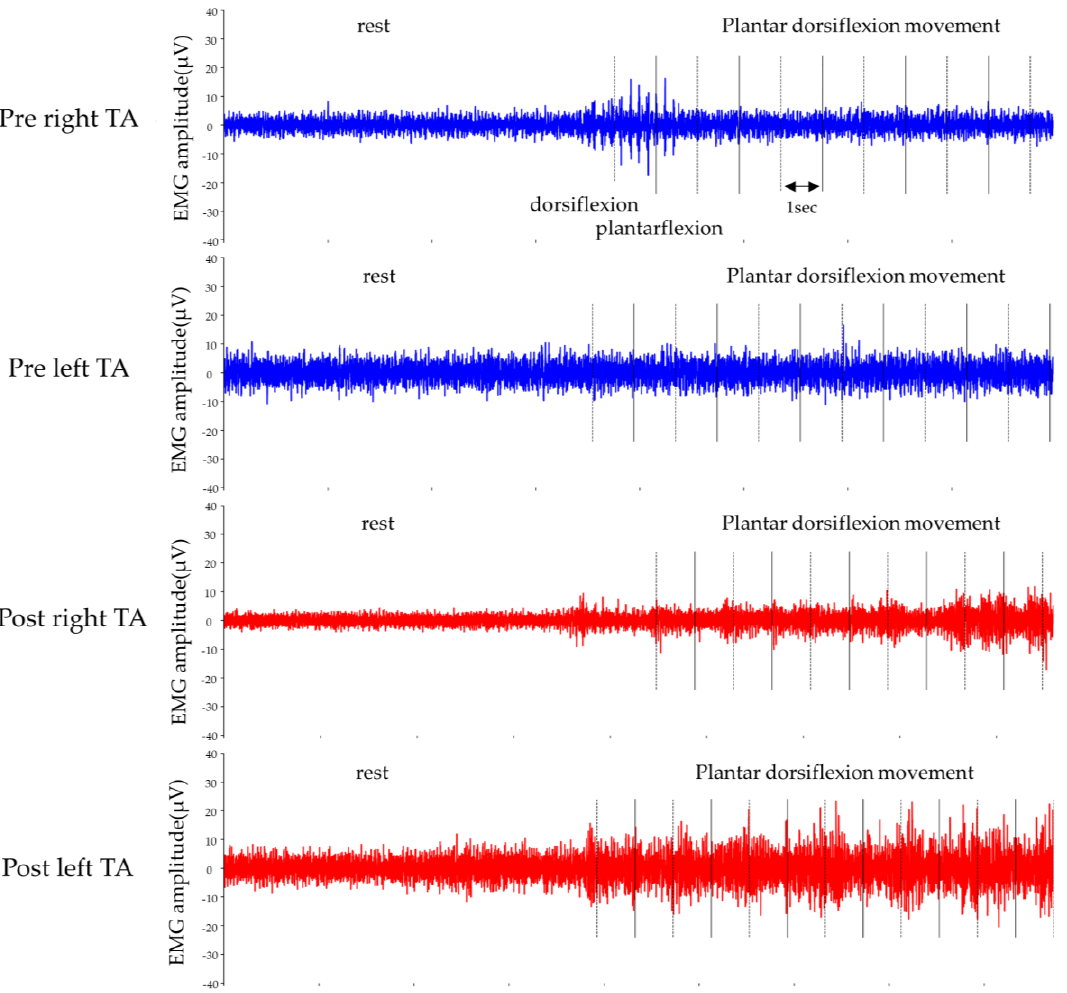
Figure 4. Raw EMGs of the left and right tibialis anterior (TA) muscles during ankle joint plantar- dorsiflexion movement in the end-sitting position.